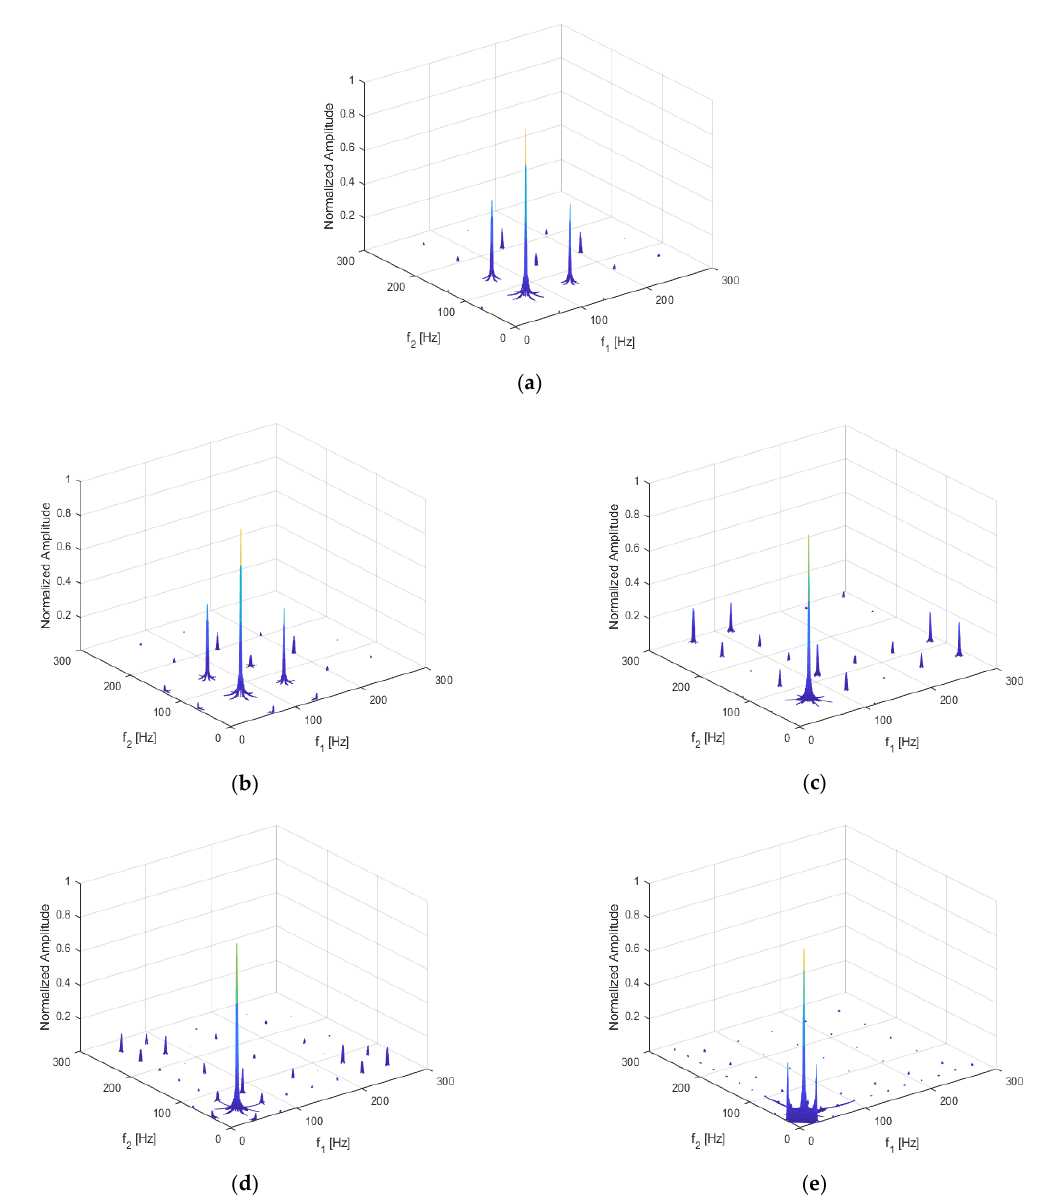
Figure 8. Bispectrum when ( a ) q = 5%; ( b ) q = 10%; ( c ) q = 30%; ( d ) q = 50%; ( e ) q = 70%.